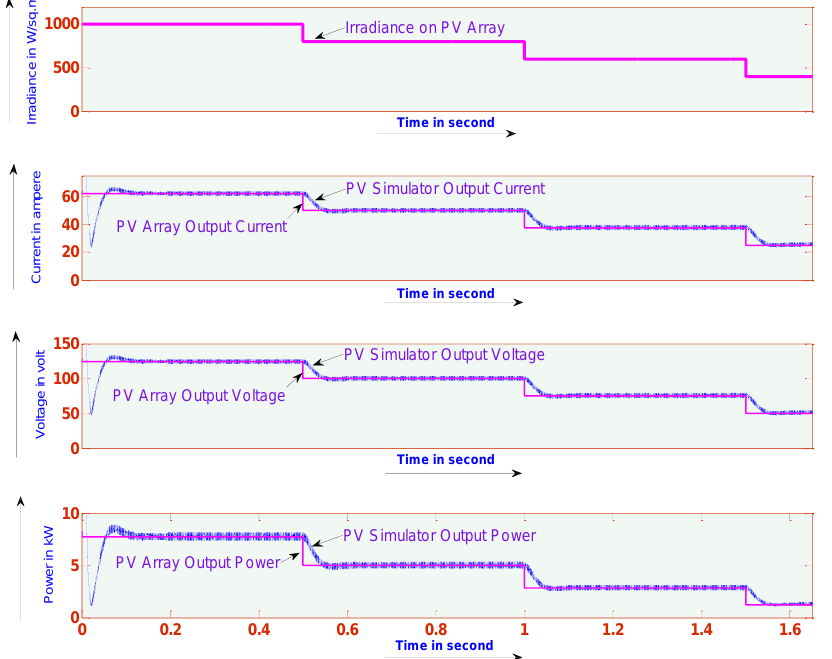
Figure 7. Output Voltage, Current and Powers from an Actual PV array and the PV-simulator for Different Irradiance Values.